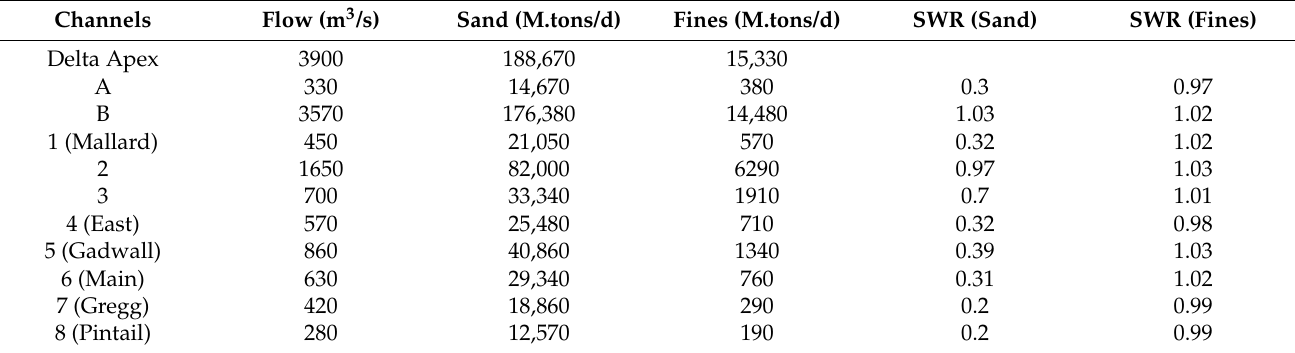
Table 2. Flow and sediment distribution in the WLD channels during river flood.